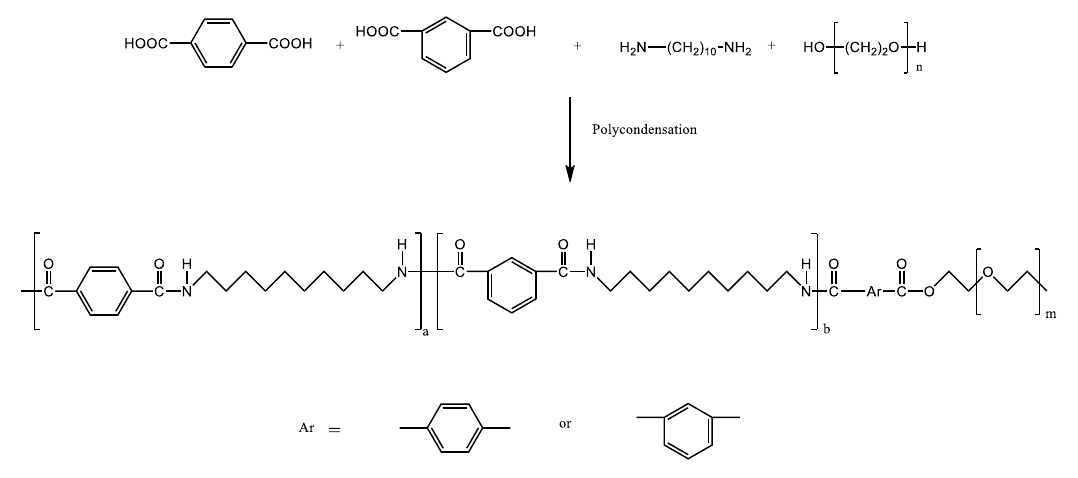
Scheme 1. The synthetic route of Table 1. Feeding mass of ingredients for preparation thermoplastic polyamide elastomers (TPAEs) and PA10T/10I.